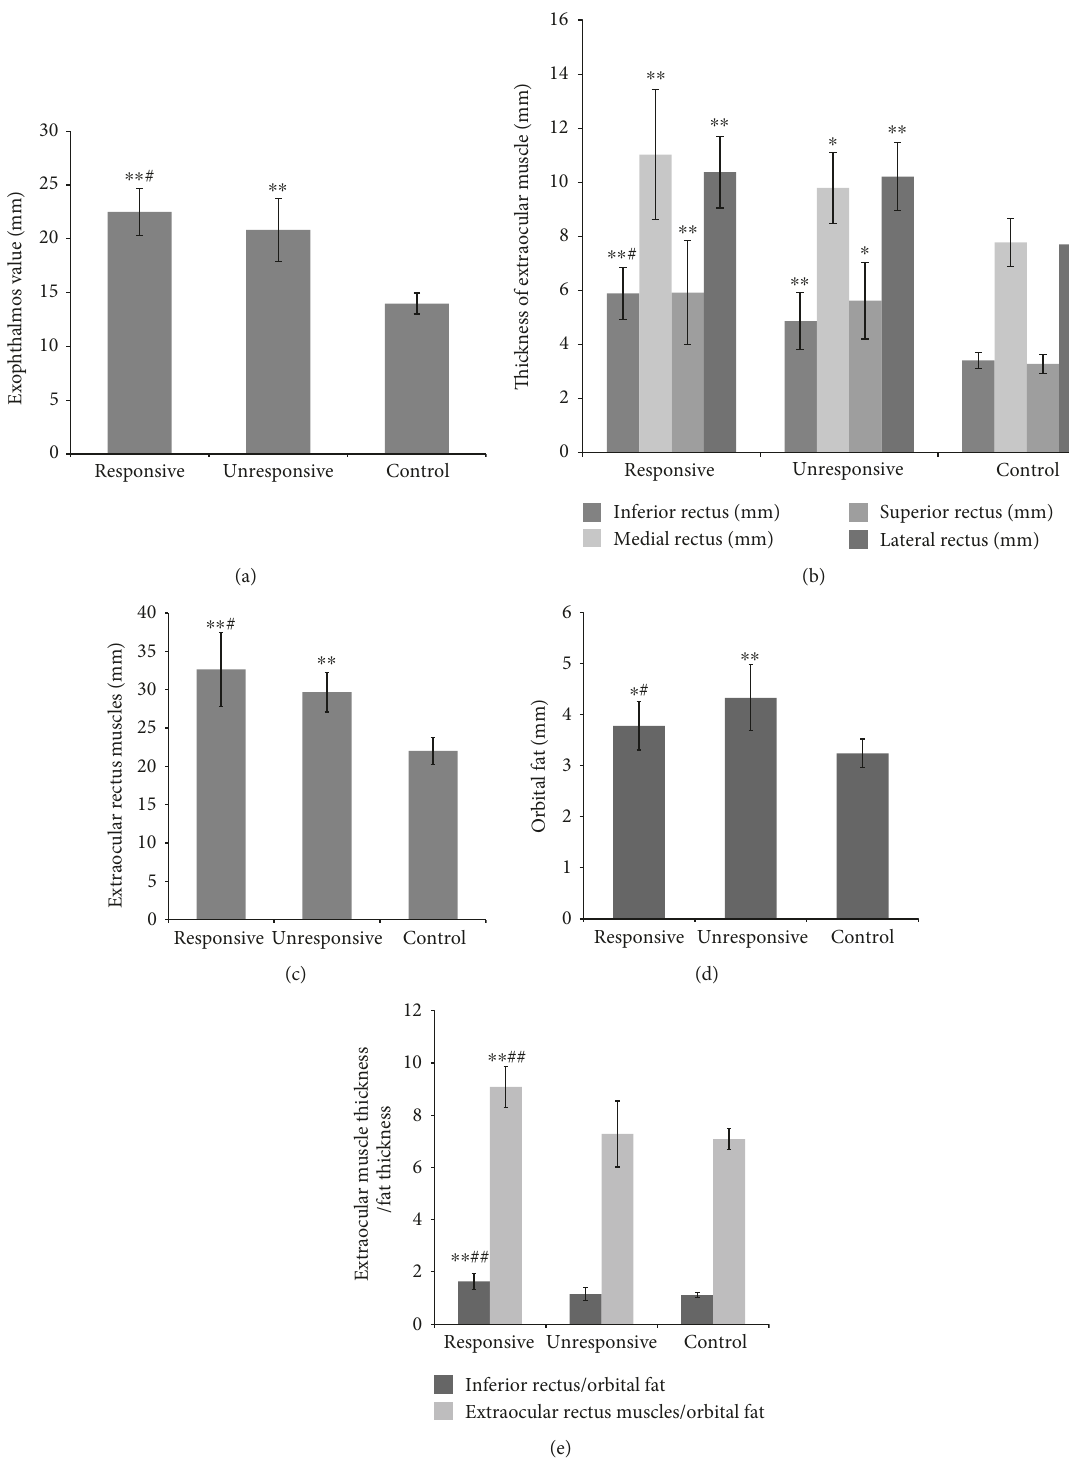
Figure 2: Comparison of ophthalmic parameter measurement in MRI. ∗ P < 0 05 versus the control group; ∗∗ P < 0 001 versus the control group; # P < 0 05 versus the unresponsive group; ## P < 0 001 versus the unresponsive